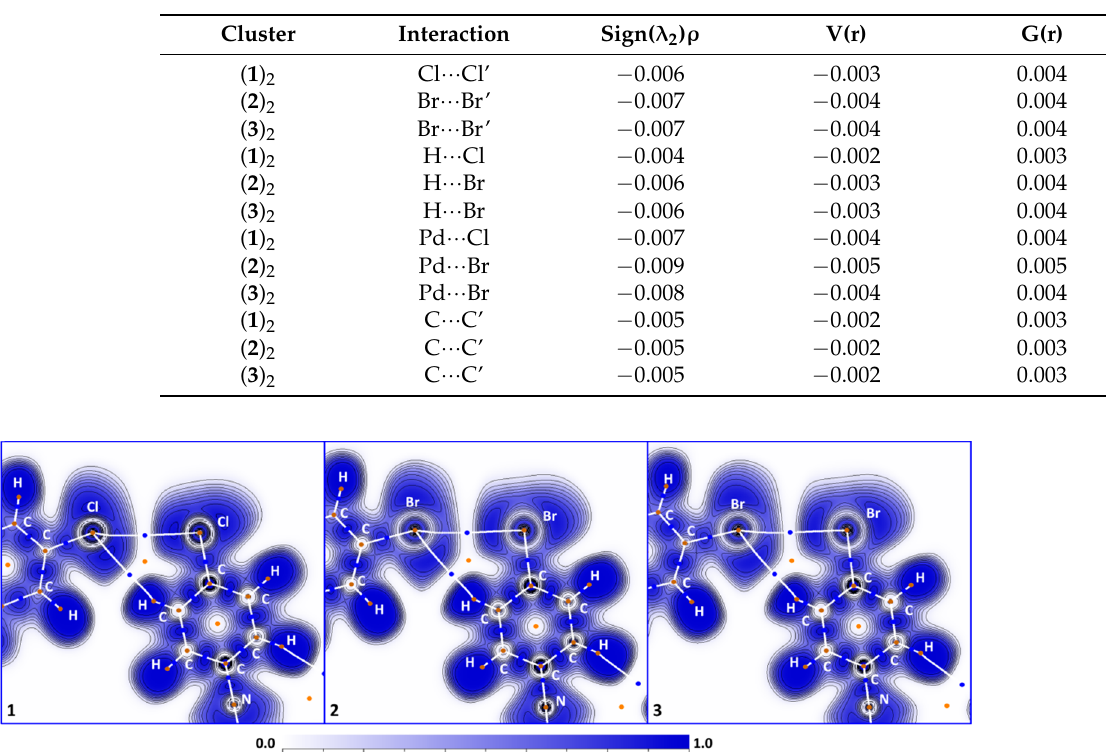
Table 2. Values of the density of all electrons with λ 2 sign—sign( λ 2 ) ρ , potential energy density— V( r ), Lagrangian kinetic energy—G( r ) (a.u.) at the BCPs, corresponding to different noncovalent